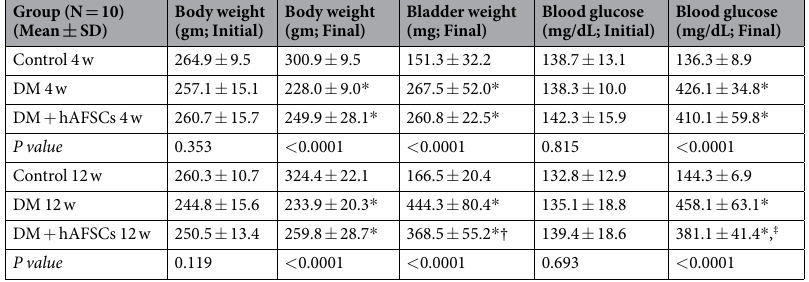
Table 1. Blood glucose and body and bladder weight in control, diabetic rats (DM) and diabetic rats with hAFSCs transplantation (DM + hAFSCs). † P < 0.05 vs. DM (12 w). ‡ P < 0.001 vs. DM (12 w). * P < 0.0001 vs. control (4 w and 12 w). N = 10 rats in each group. Initial body weight: body weight measured before sham treatment, STZ treatment or hAFSCs transplantation. Final body weight: body weight measured 4 w and 12 w after sham treatment, STZ treatment or hAFSCs transplantation. Final bladder weight: bladder weight measured 4 w and 12 w after sham treatment, STZ treatment or hAFSCs